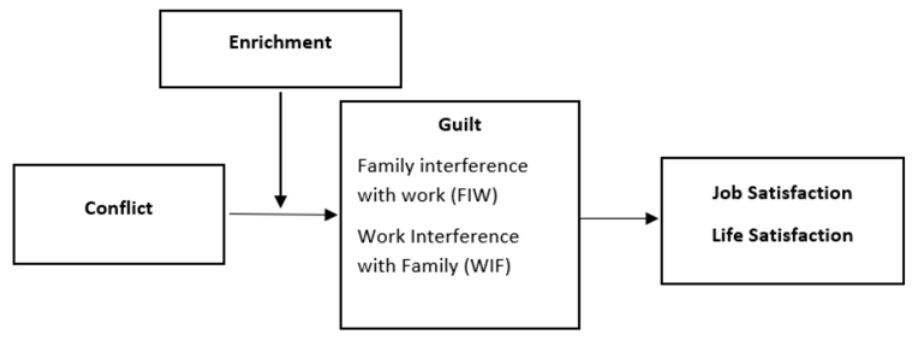
Figure 1. The proposed theoretical model.